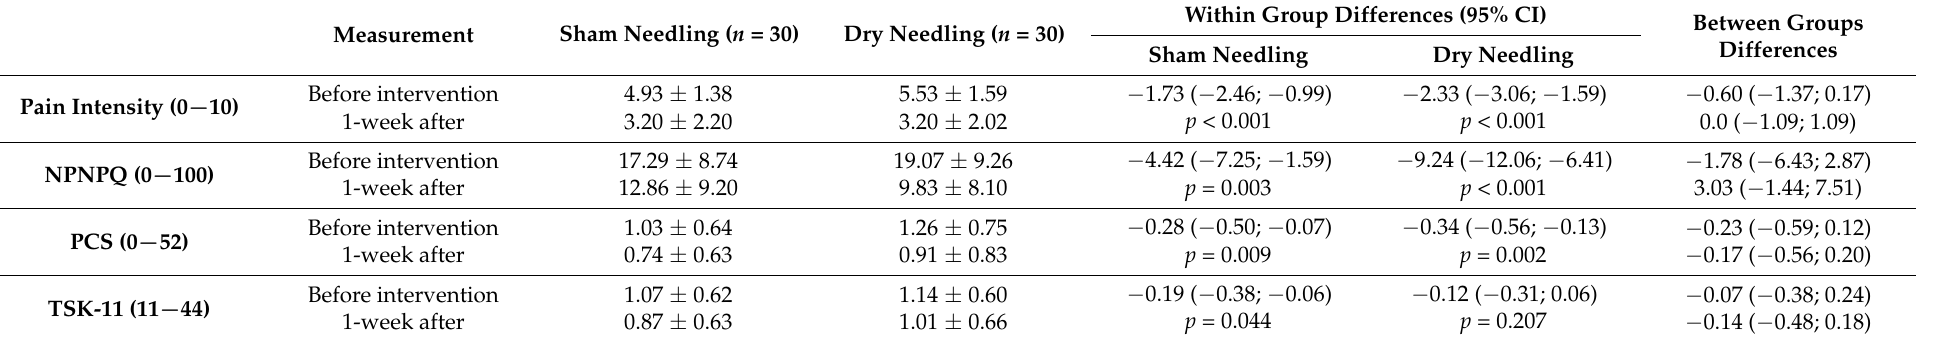
Table 3. Real and sham dry needling effects on clinical and psychological variables at one-week follow-up.